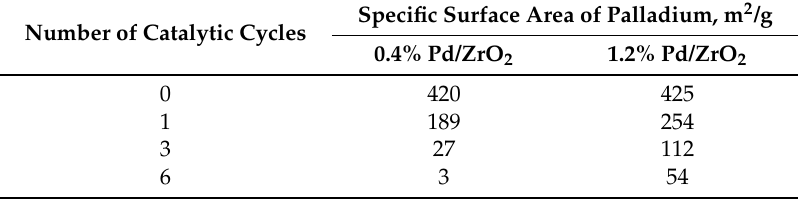
Table 4. Effect of number of catalytic cycles on specific surface area of